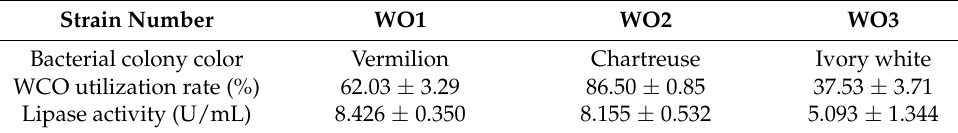
Table 1. WCO utilization characteristics of the three separated